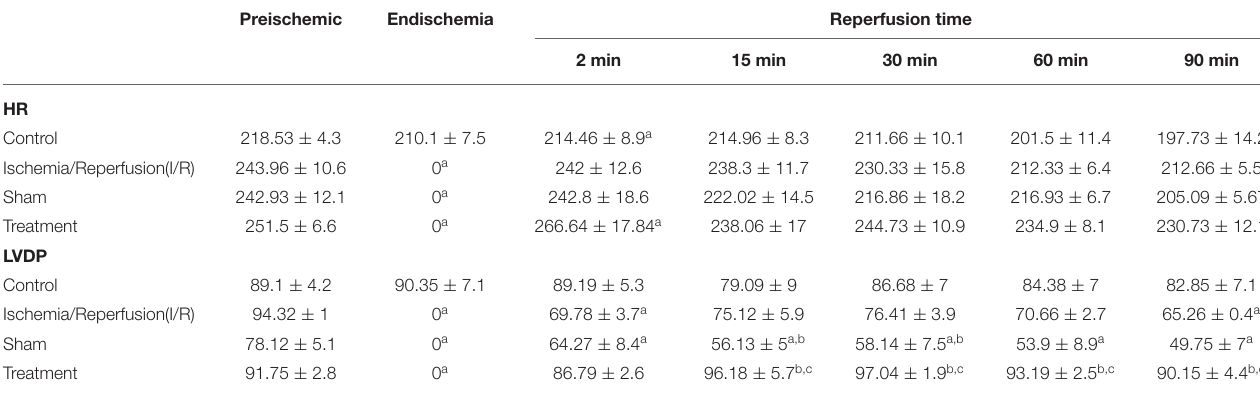
TABLE 1 | Values of the hemodynamic parameters in the non-preconditioned and preconditioned hearts are measured at the different phases of preischemia and postischemia. Preischemic Endischemia Reperfusion